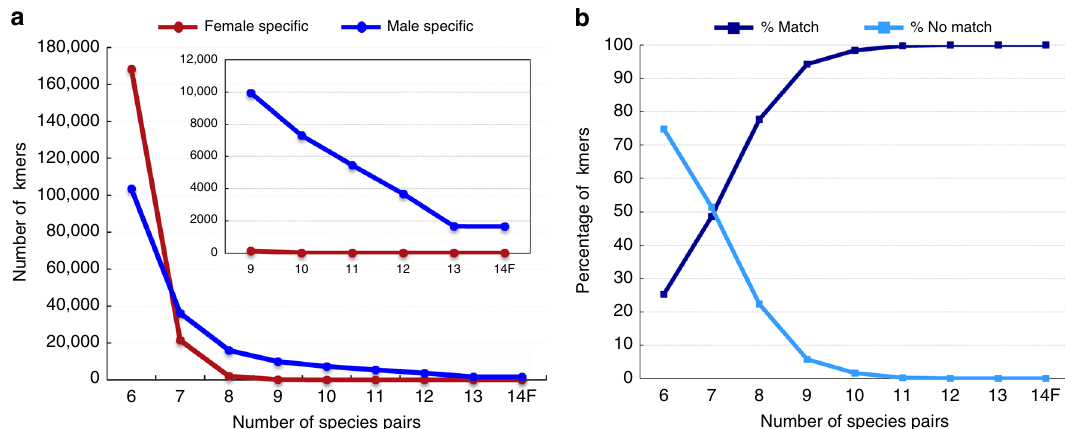
Fig. 1 Identi fi cation of male-speci fi c kmers in the genus Phoenix . a Sixteen base pairs kmers identi fi ed only in the male (blue) or female (red) individual for each species were tested for their presence in other species. As expected for an XY sex determination system, kmers speci fi c to males maintained counts through all species tested while female-speci fi c kmers disappeared after requiring presence in more than eight species. b Kmers speci fi c to male Phoenix enumerated against the male-speci fi c BAC contigs. Kmers speci fi c to males in at least 12 species are fully covered by the sequenced BACs in this study (dark blue — % kmers matching BACs, light blue — % kmers not matched to BACs). Only a female was available for Phoenix pusilla comparisons (14F)